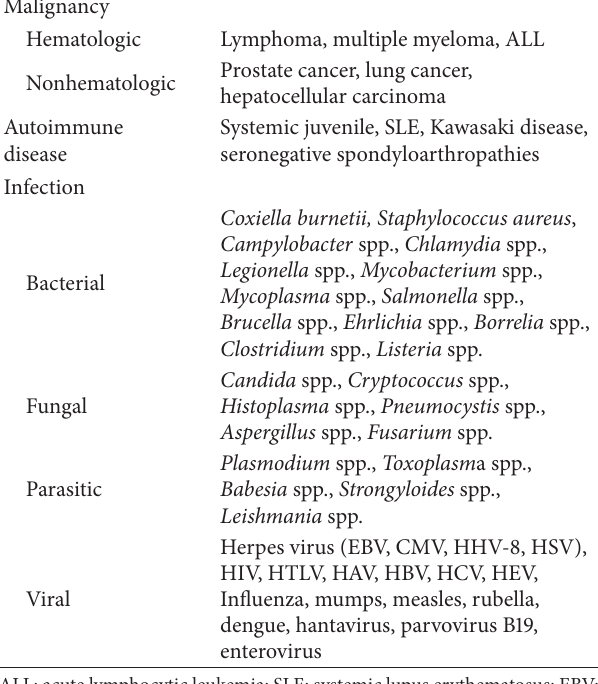
Table 2: Trend of laboratory work after discharge and during the second hospital stay.